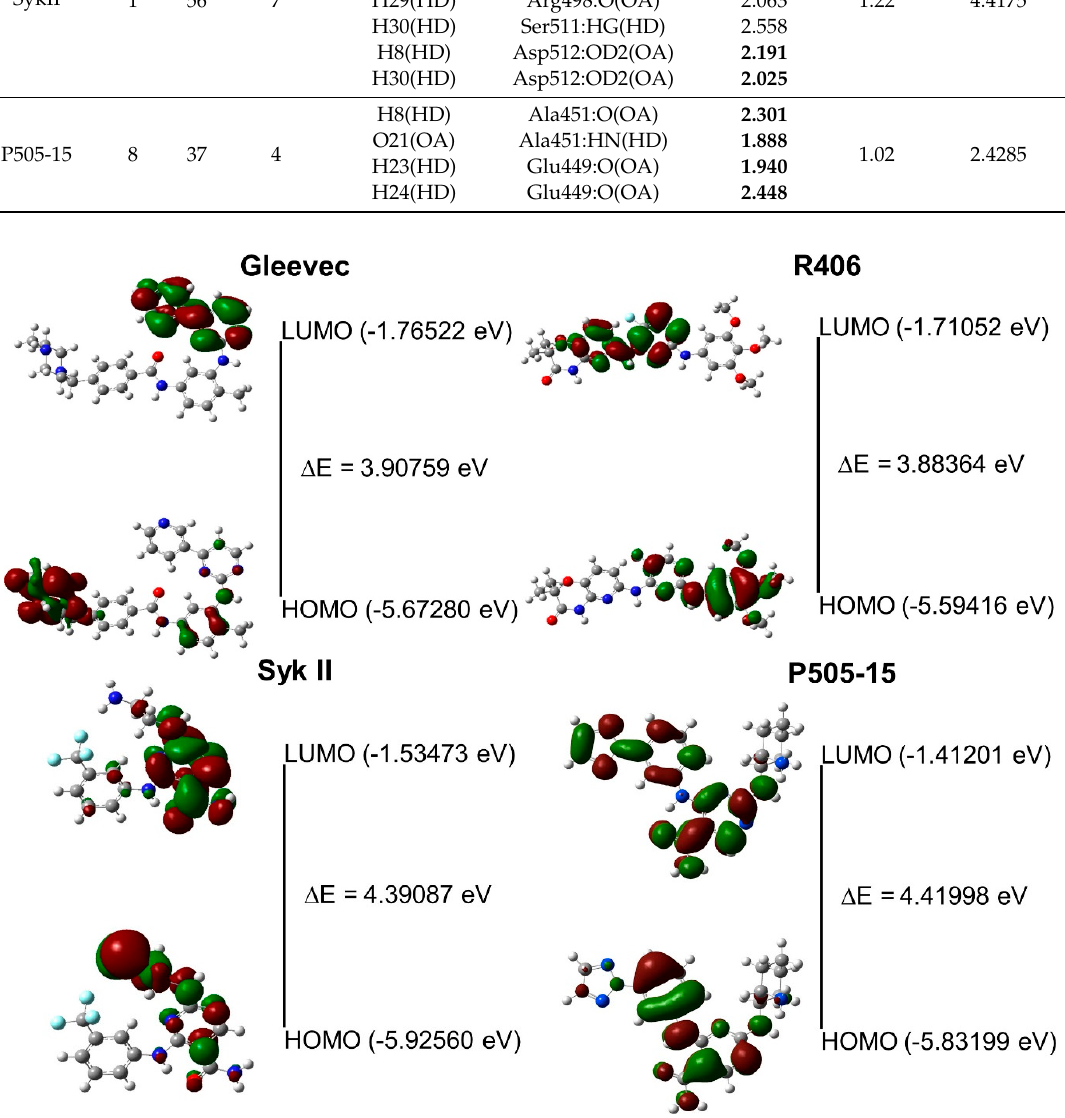
Figure 3. The most probable statistical positions in the highest occupied molecular orbital–lowest unoccupied molecular orbital (HOMO-LUMO) descriptor values.